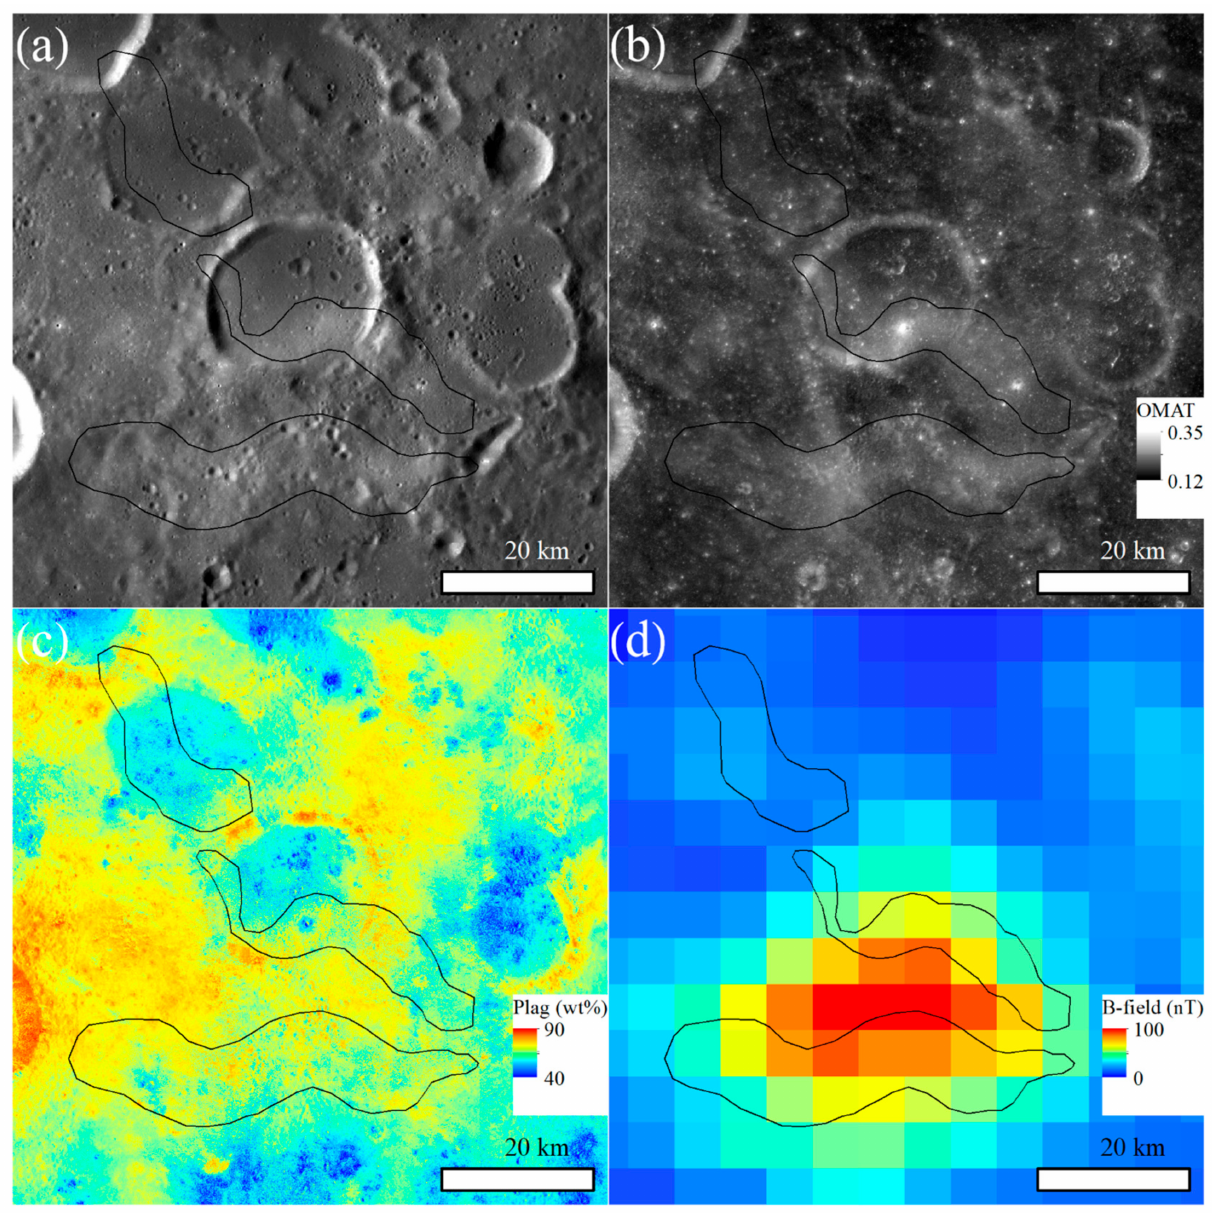
Figure 14. Swirls (14.9 ◦ S, 51.8 ◦ E) on the west of Mare Fecunditatis. ( a ) WAC image; ( b ) MI OMAT image (brighter tones indicate lower maturity); ( c ) MI Plagioclase abundance; ( d ) SVM magnetic field magnitude